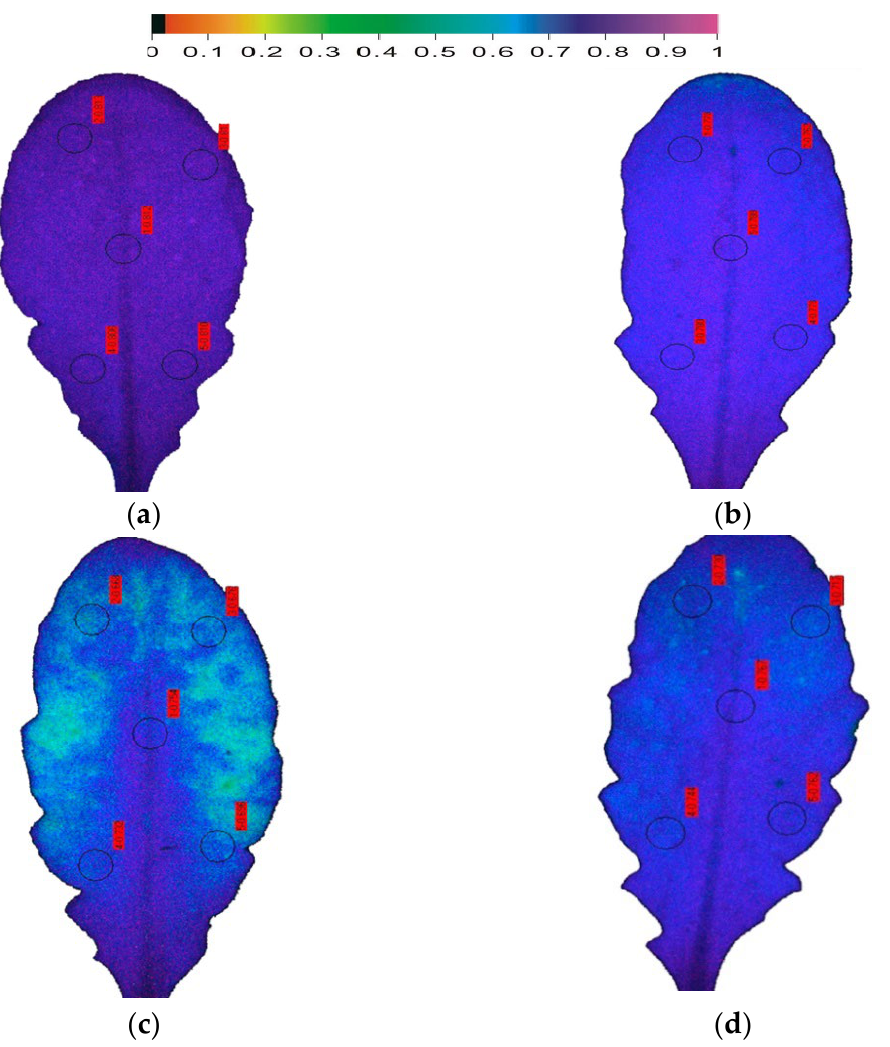
Figure 3. Color-coded leaf images of the maximum efficiency of Arabidopsis thaliana PSII photochem- istry (F v /F m ). F v /F m decreased from the control value of 0.811 ( a ), with the onset of drought stress (OnDS) to 0.775 ( b ), and decreased further to 0.714 under mild drought stress (MiDS) ( c ); while under further water deficit treatment, F v /F m recovered to 0.743 at moderate drought stress (MoDS) ( d ).